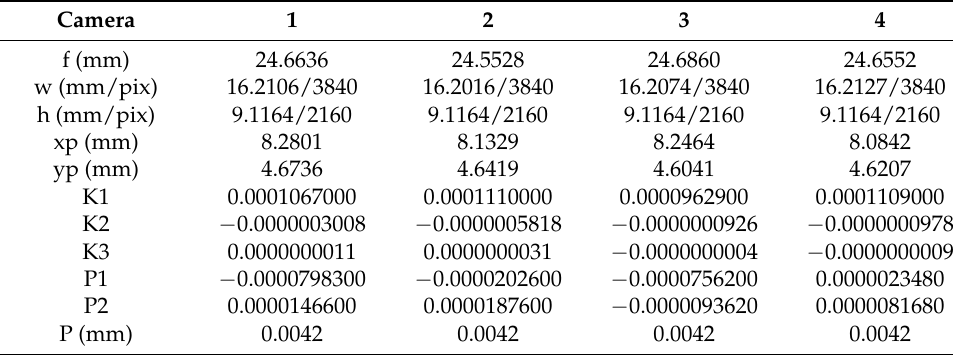
Table 1. Elements of interior orientation for individual cameras.